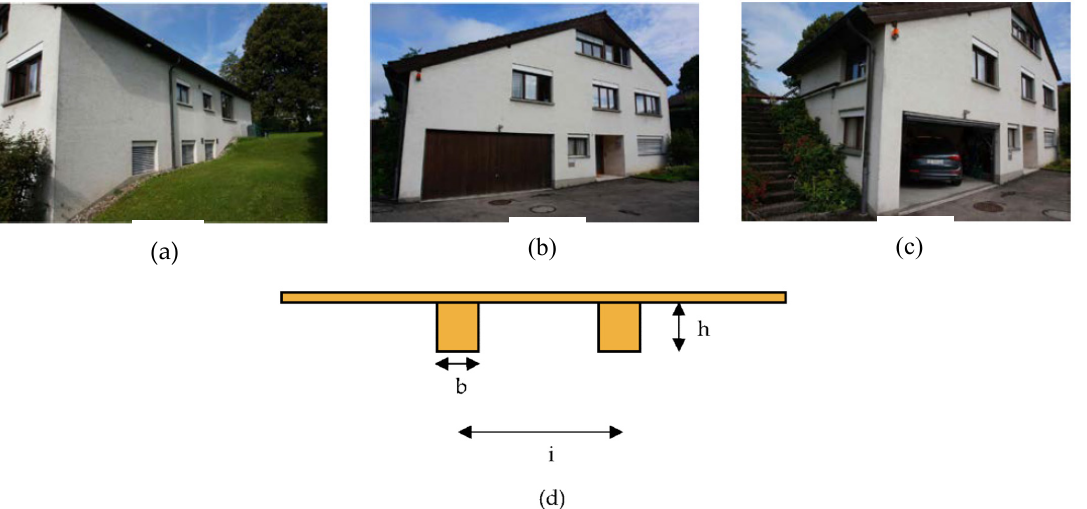
Figure 1. ( a ) North-east facade ( b ) south-east facade ( c ) south-west facade and ( d ) timber floor diaphragm of the building. Table 1. Floor system consisting of timber beams with wooden planking.